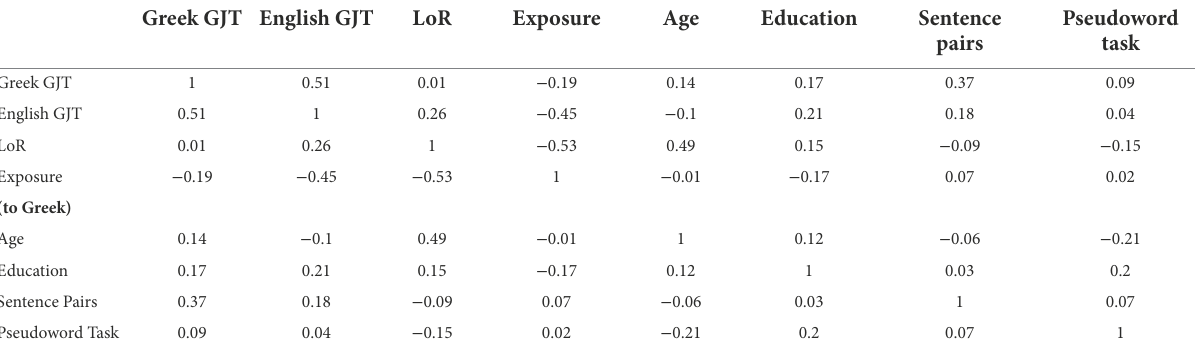
TABLE 4 Pairwise correlations between all the variables.